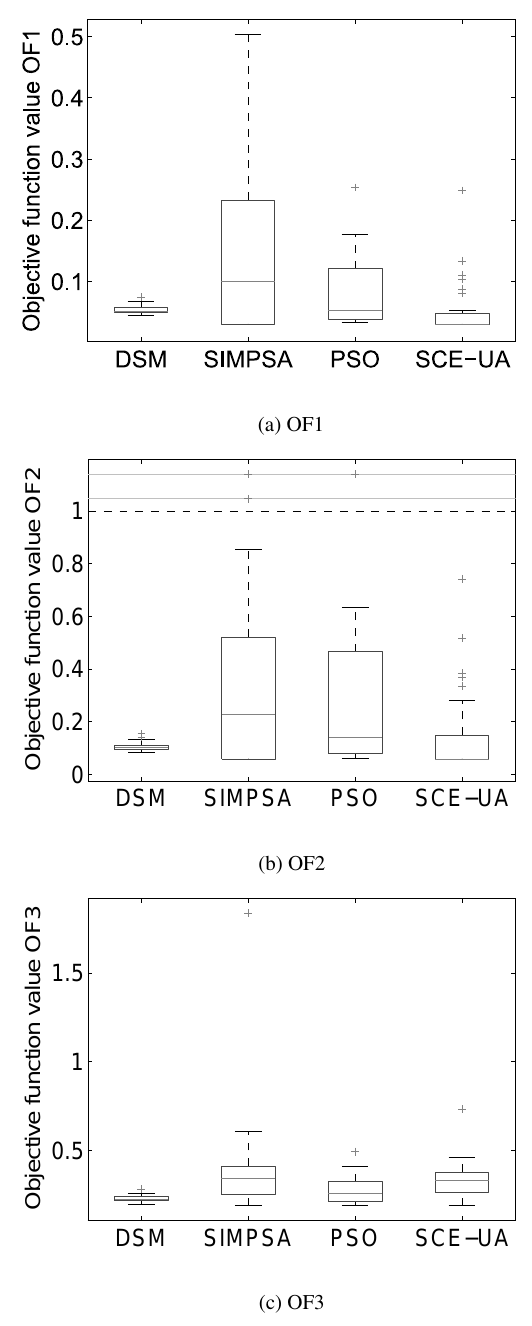
Fig. 7: Box plots comparing calibration results of DSM, SIMPSA, PSO and SCE-UA. All months and repetitions are lumped together, no averages have been taken.